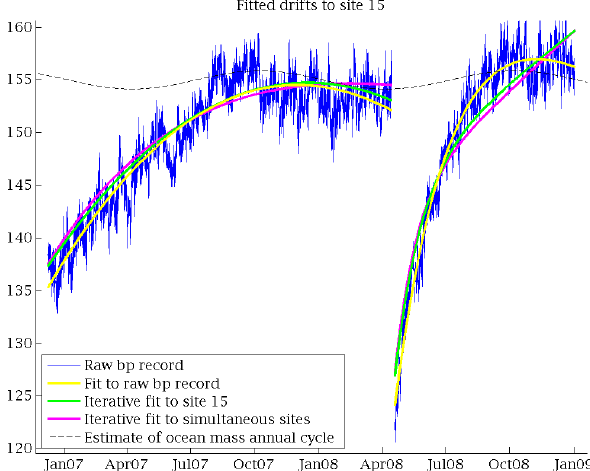
Figure 3. Drift fitting to site 15. The yellow line is the fit to the raw bp record (blue), without taking account of the annual mass signal or other corrections. Green is the iterative fit to just that site, and magenta is the fit with the annual fitted to all sites simultaneously (discussed